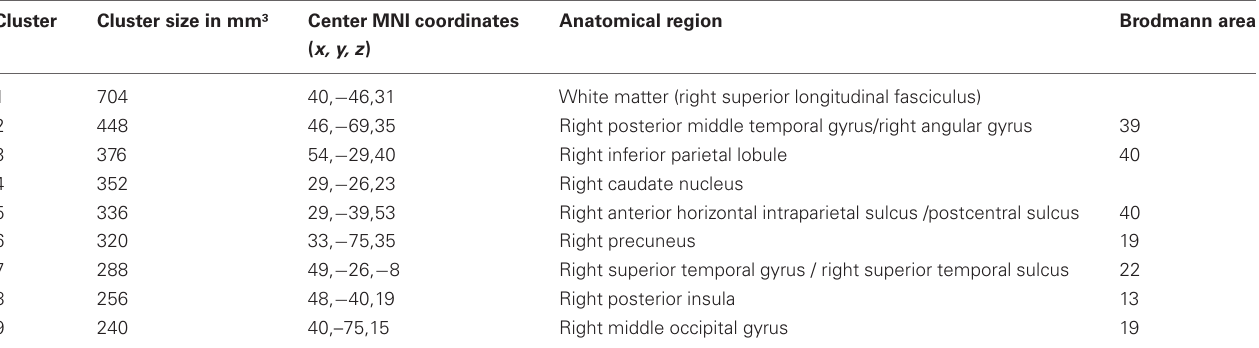
MRIcron. Numbers in parentheses are x , y , and z coordinates of the center of the cluster in MNI space. All lesion clusters are in the right cerebral